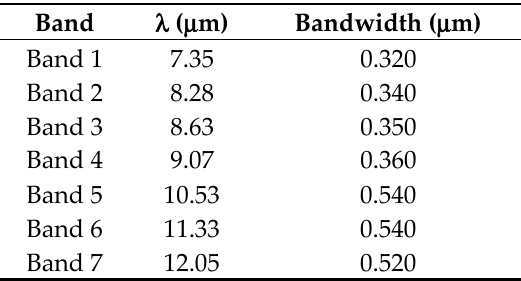
Table 1. HyspIRI TIR spectral